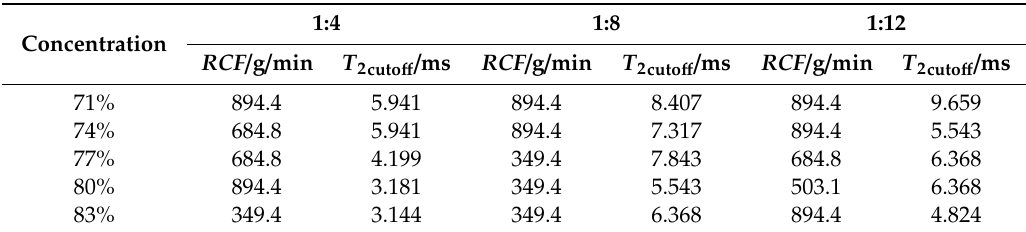
Table 4. The optimal centrifugal force and T 2 cuto ff data.